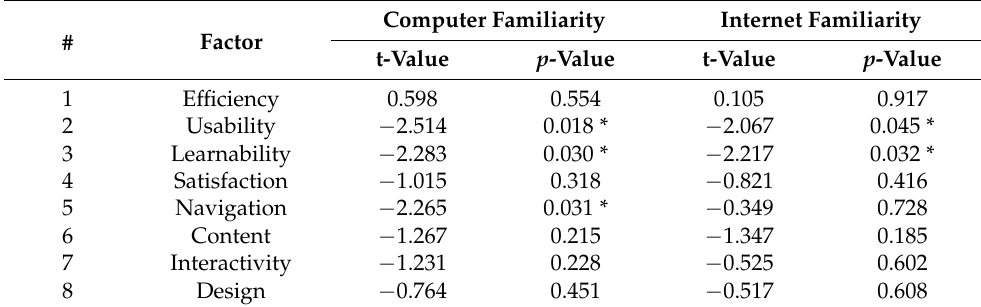
Figure 6. Average evaluation scores of the two groups for computer and internet familiarity variables. Table 6. T-tests results for correlation between the evaluation factors and the groups of computer and Internet familiarity variables.